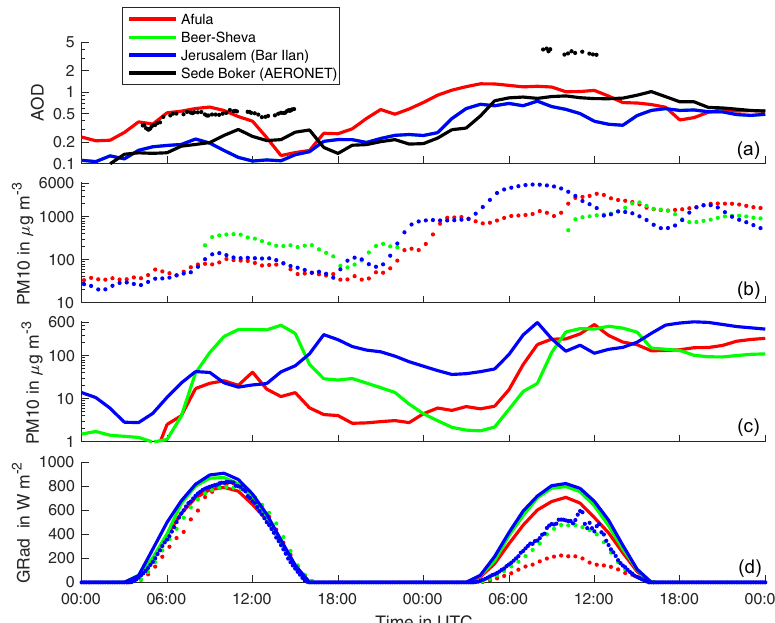
Figure 8. Observations and model results for three stations in Israel for 7 and 8 September. Points denote observations, and solid lines denote model results. Please note the logarithmic y -axis scaling, which differs by a factor of 10 between the second and third sub-plot. Shown are (a) modelled DOD and AERONET measurements for Sedé Boqer; (b) measured PM 10 concentrations; (c) modelled PM 10 concentrations; (d) global radiation (GRad) – the values shown are for Afula, Beer-Sheva and Jerusalem due to data